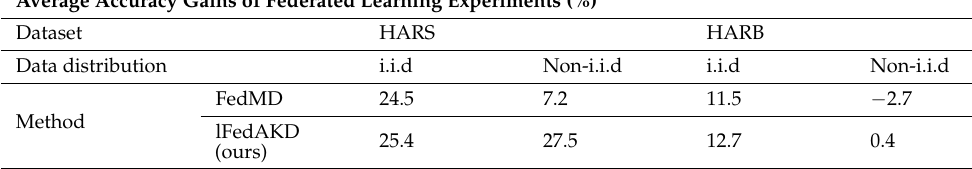
Table 5. Summary of the numerical results of the FL experiments on both the HARB and HARS datasets. Our proposed FL algorithm FedAKD outperforms FedMD on both datasets under i.i.d and non-i.i.d statistical scenarios.